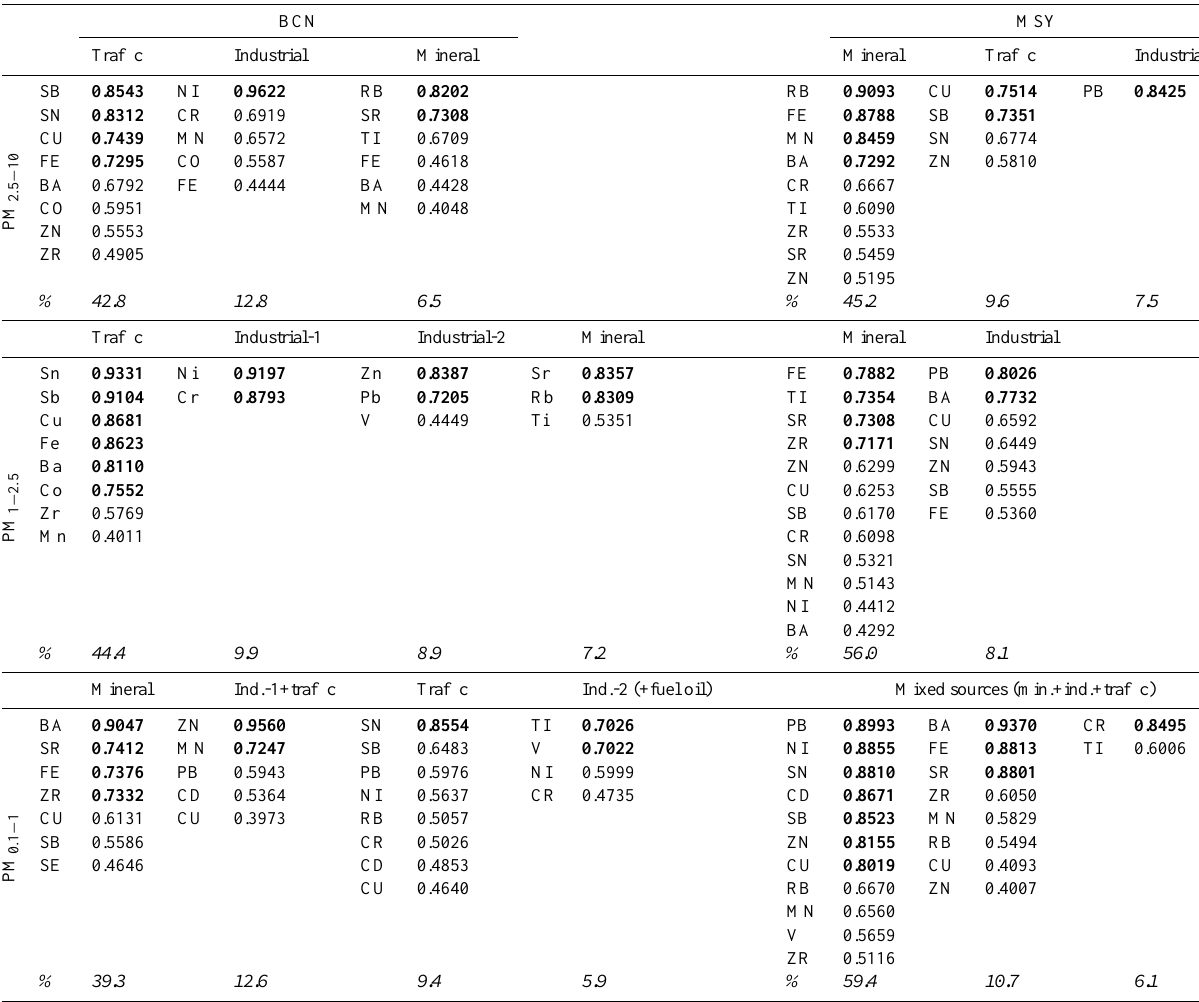
Table 4. Main factors identified by Principal Components Analysis for the trace metals analysed in the three size fractions measured at BCN and MSY during the winter campaign. (%: variance percentage of each